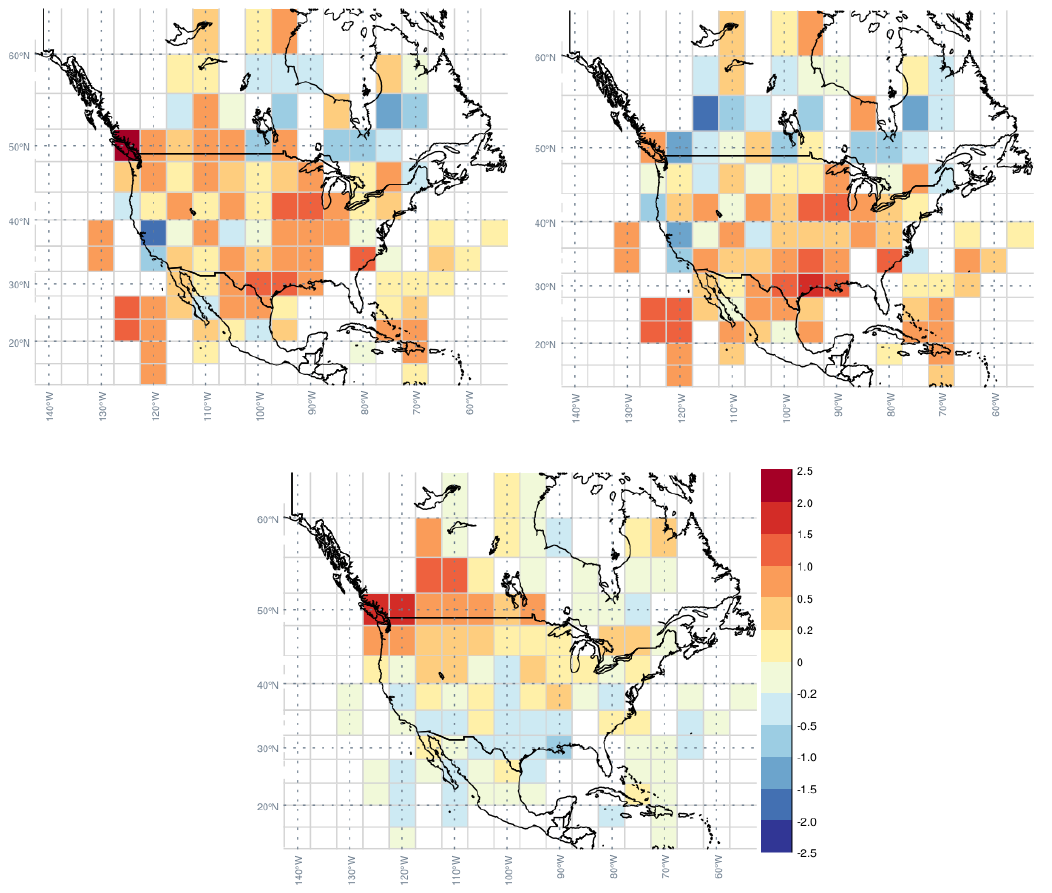
Figure 8. Summer mean model-data differences (bias) for the year 2010 between GOSAT ACOS XCO 2 measurements and WRF ( left panel ), CMS (GEOS-Chem, right panel ), and differences between the two ( lower panel